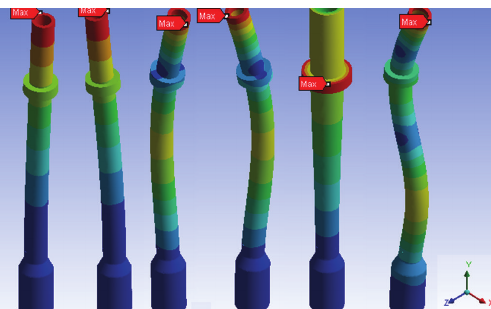
Figure 5: Mode shapes of the minaret model strengthened with FRCM wrapping (Modes 1 to 6 are lined from left to right).